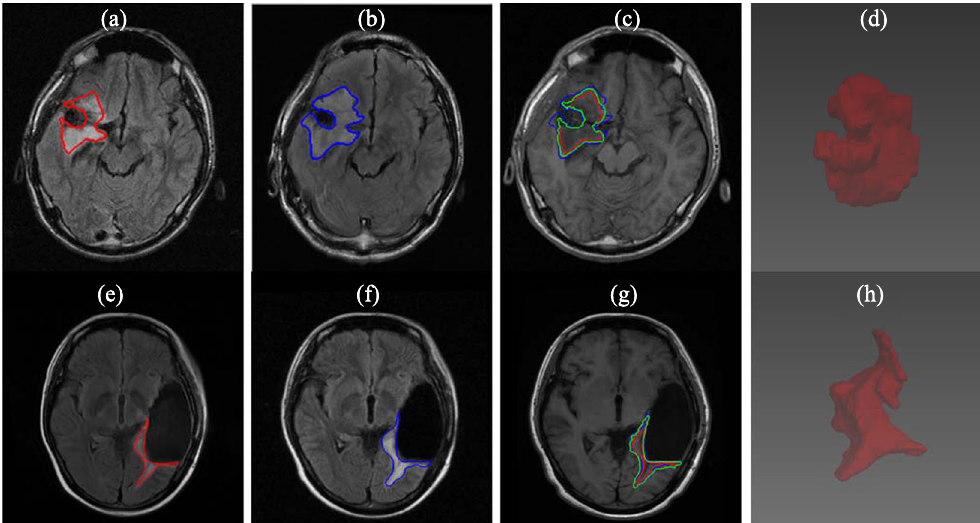
Figure 5. Simulation results of tumor growth from 2 LGG patients who underwent surgery followed by chemotherapy and radiotherapy. The red ( a , e ) and blue ( b , f ) contours represent the ground truths of tumor boundaries on2 serial T2 MR images while the green contours ( c , g ) are the simulated growths on T1 MR images. ( d ) and ( h) are constructed 3D views of the simulated tumor growth.